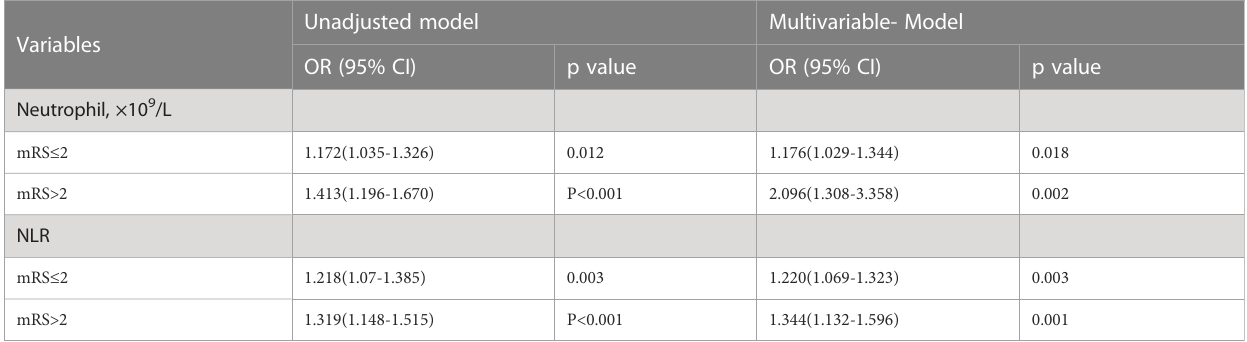
TABLE 4 Unadjusted and adjusted analyses of neutrophil and NLR with high SHR group according to discharge functional outcomes subgroup.